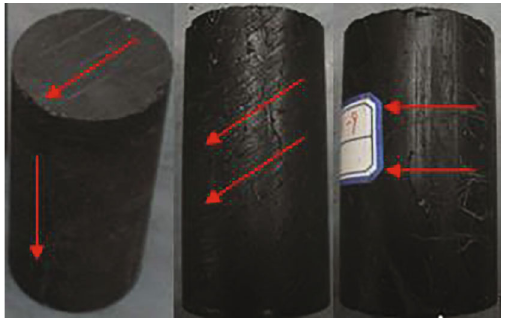
Figure 2: Standard prepared coal rock